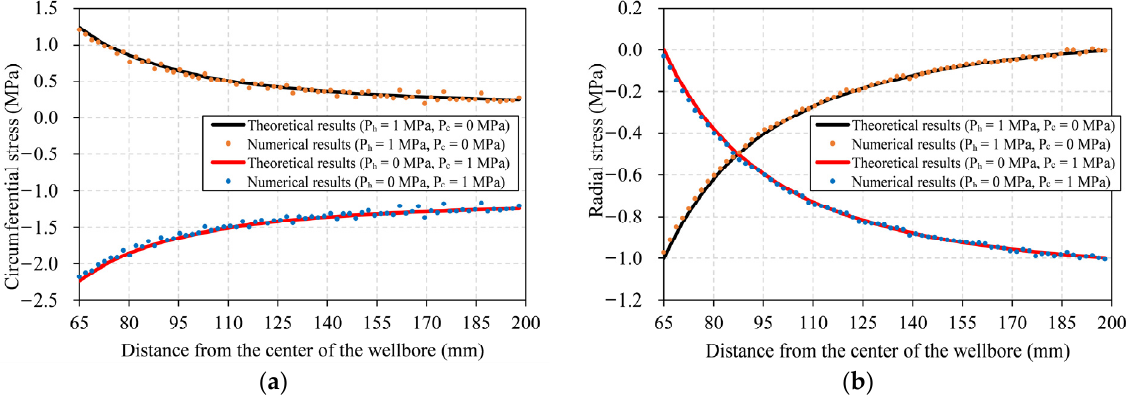
Figure 8. Comparison of numerical and theoretical static stresses: ( a ) circumferential stress and ( b ) radial stress.